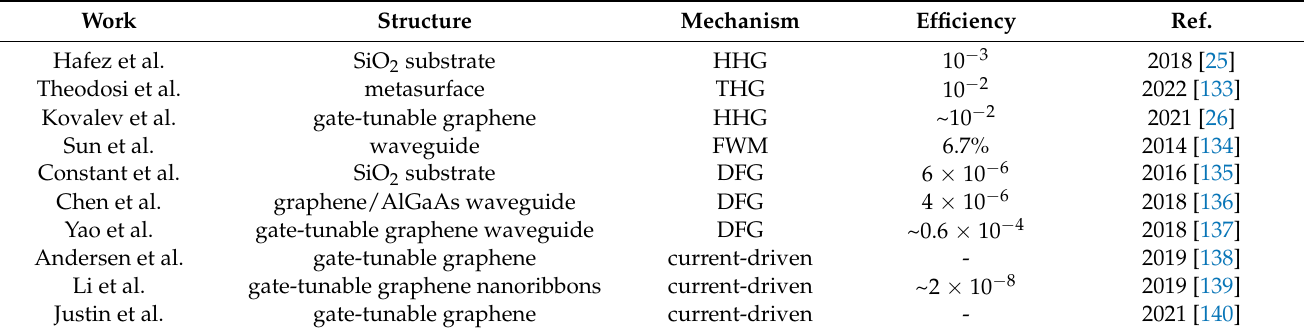
Table 4. Summary of THz